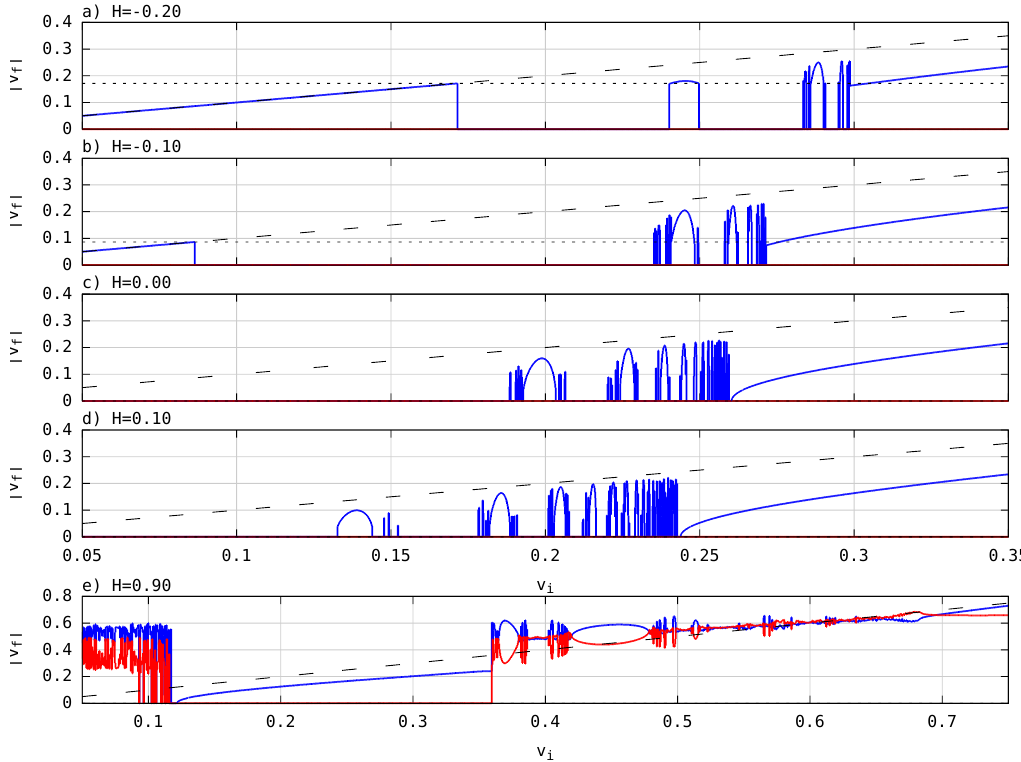
Figure 2 . Final antikink velocities as functions of initial velocities. The dashed line indicates the result for a purely elastic collision. In the (cid:12)fth plot, a kink can also be produced: its velocity is shown in red. The horizontal dotted lines in plots a and b show the relevant values of v cr ( H ), as given by equation (4.2)